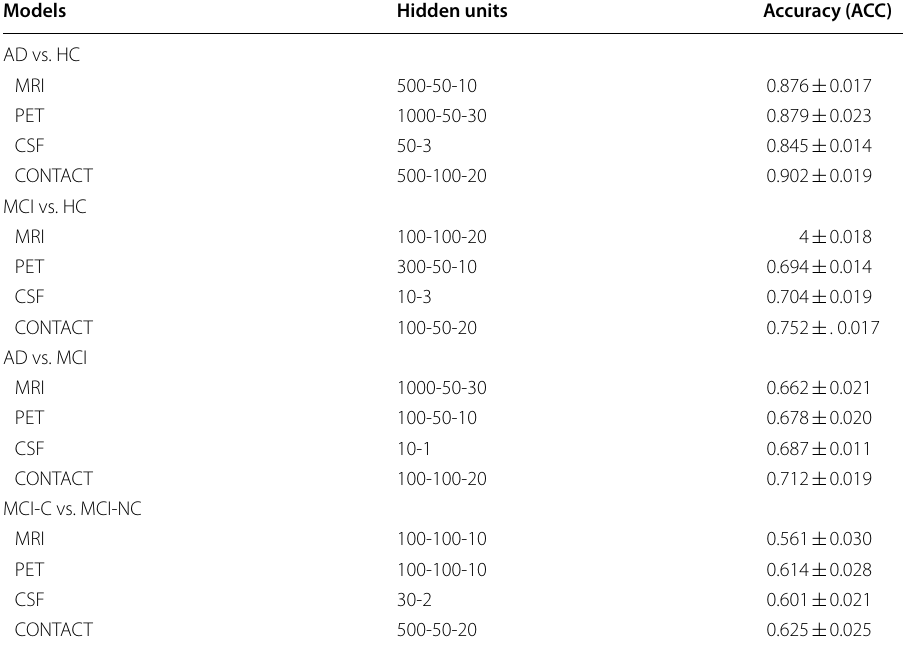
Table 3 Classification accuracy derived from the SP classification and the relevant structure as the number of hidden